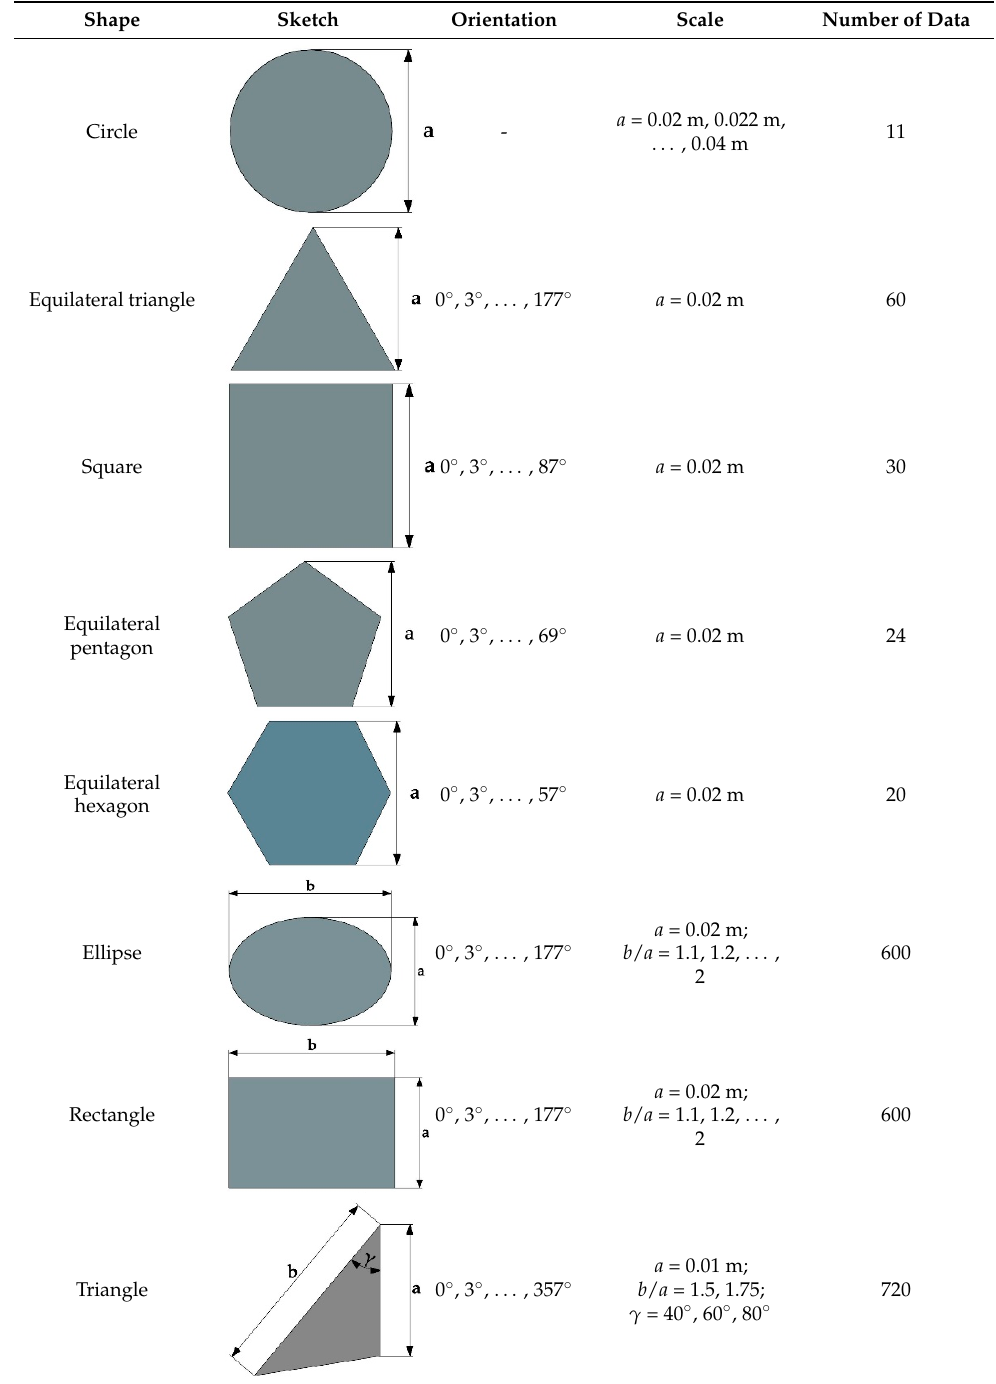
Figure 1. Numerical domain.